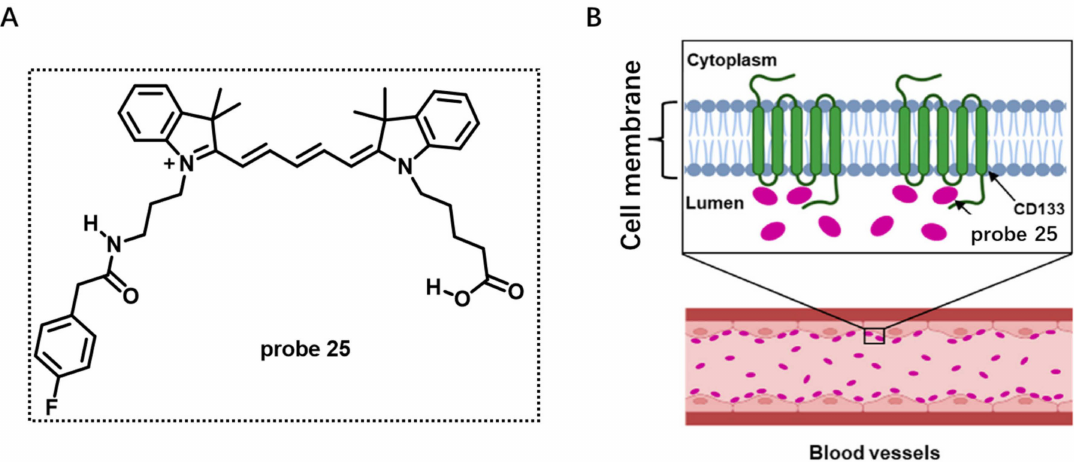
Figure 25. ( A ) Chemical structure of probe 25 . ( B ) The binding site of probe 25 on CD133 protein surface marker of endothelial cells. Copyright 2022 Elsevier